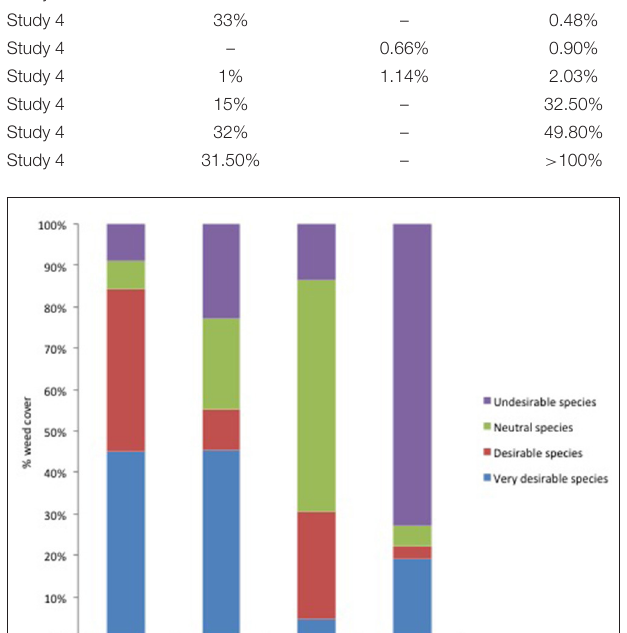
annua (seven dependent invertebrate species, three of which were red listed), and P. aviculare (four dependent species, two